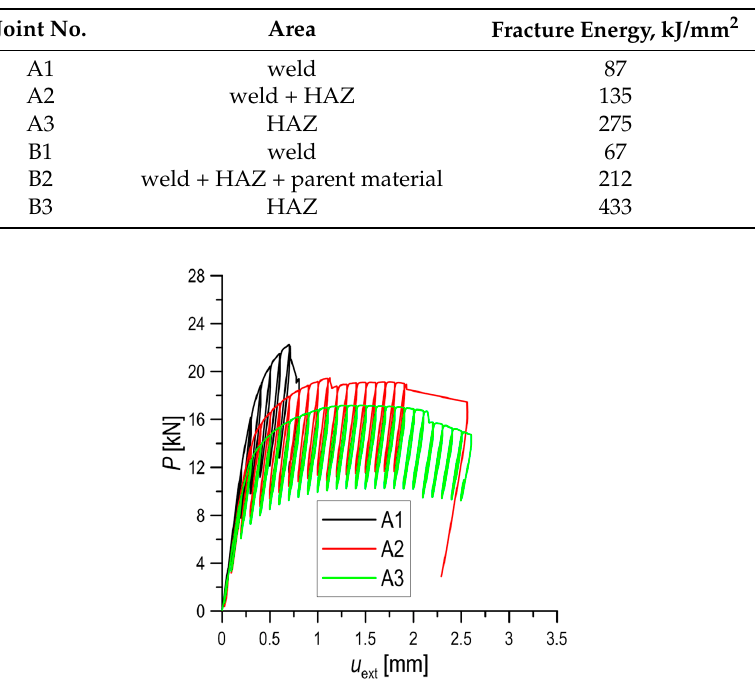
Figure 7. Force-displacement diagram for welded joint tests for unmodified cast steel (A series).